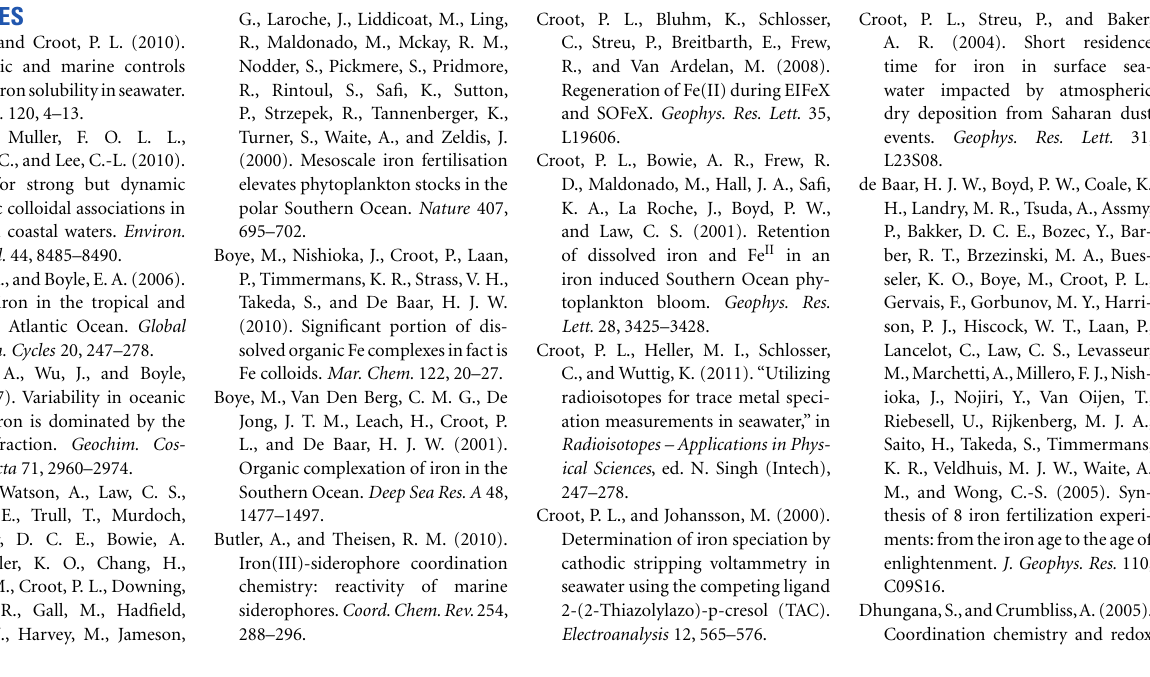
additionally provide other oxidants or reductants that react